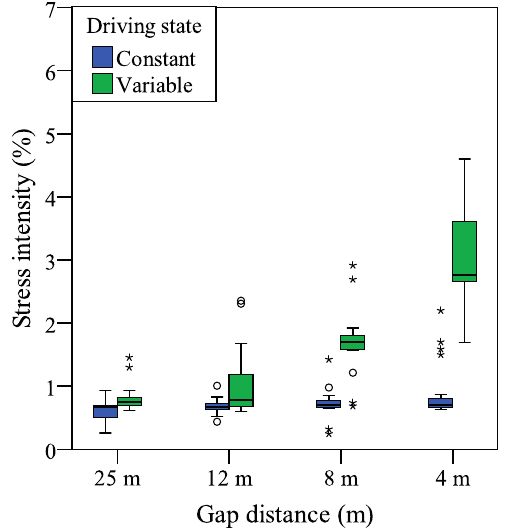
Figure 8. Stress intensity estimated from palmar perspiration. Depending on the interquartile range for the box plot, outliers are indicated by circles (1.5–3) or stars